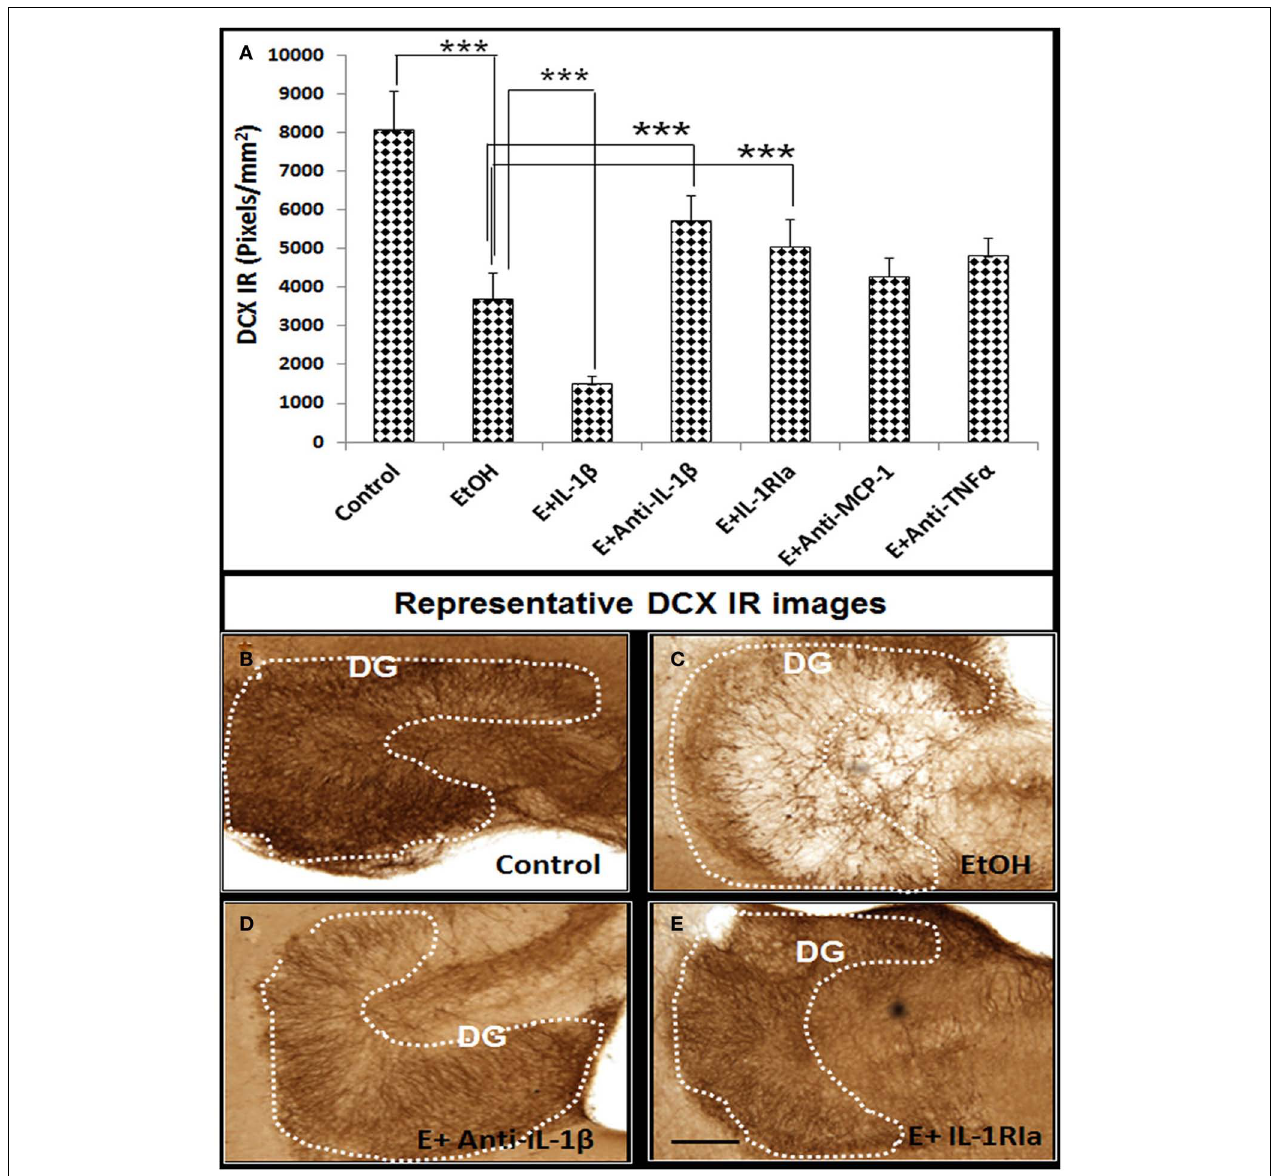
IL-1 β and reversed by addition of neutralizing anti-IL-1 β antibody or blockade of IL-1 surface receptors. ANOVA F (6, 38) = 11.27, p < 0.0001, and Fisher post hoc : *** p < 0.001 compared with corresponding group as indicated, n = 6–8. Representative DCX + IR photographs from the groups as indicated were shown in (B–E) .The experiments were repeated at least four times with similar designs and results (scale bar = 200 μ